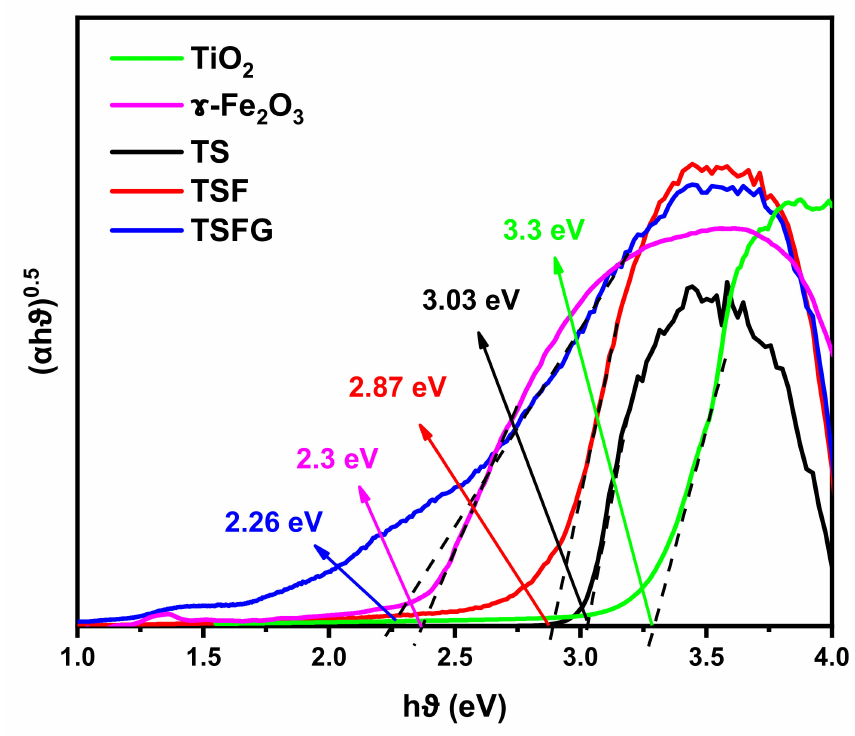
Figure 8. Tauc plots of ( α h ν ) 0.5 versus h ν were employed to estimate the band gaps of the TiO 2 , γ -Fe 2 O 3, TS, TSF, and TSFG samples.